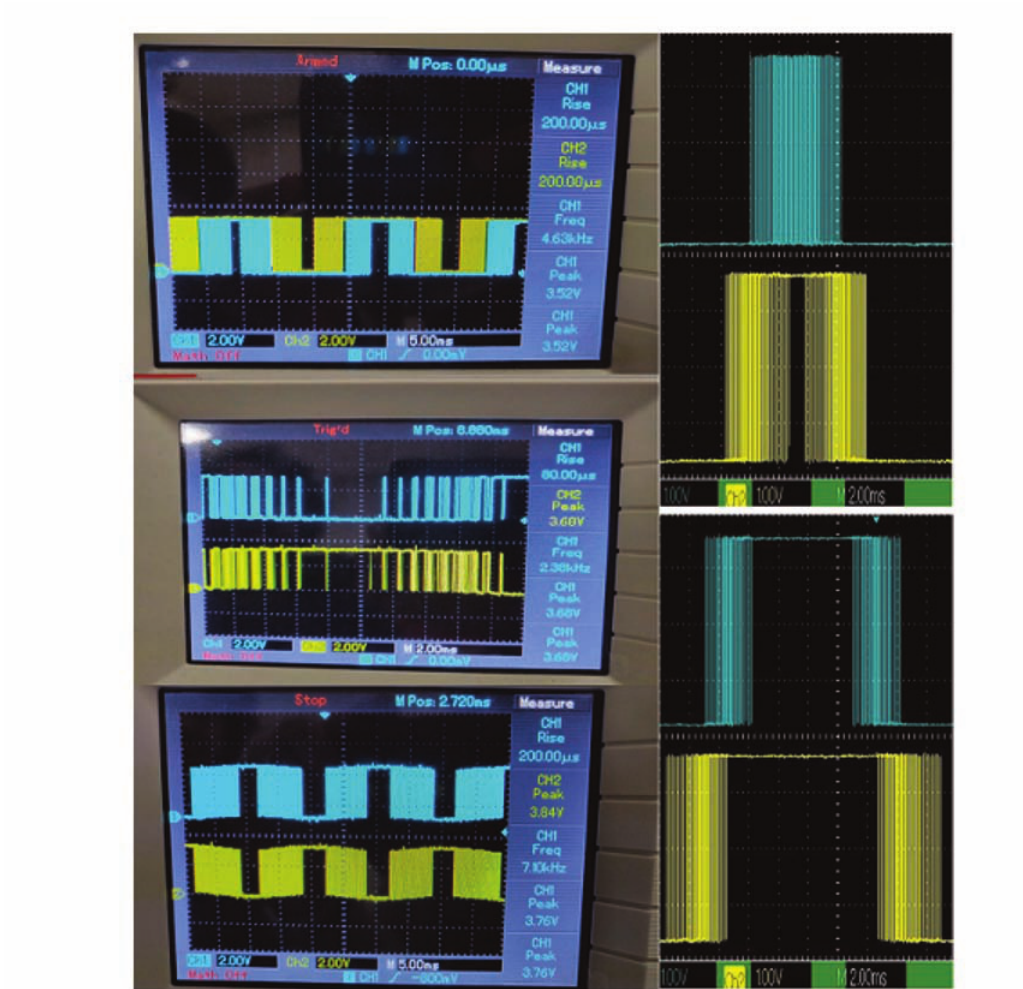
Fig. 15. Sine Pulse Width Moduulation to generate smooth sine at tthe output of the